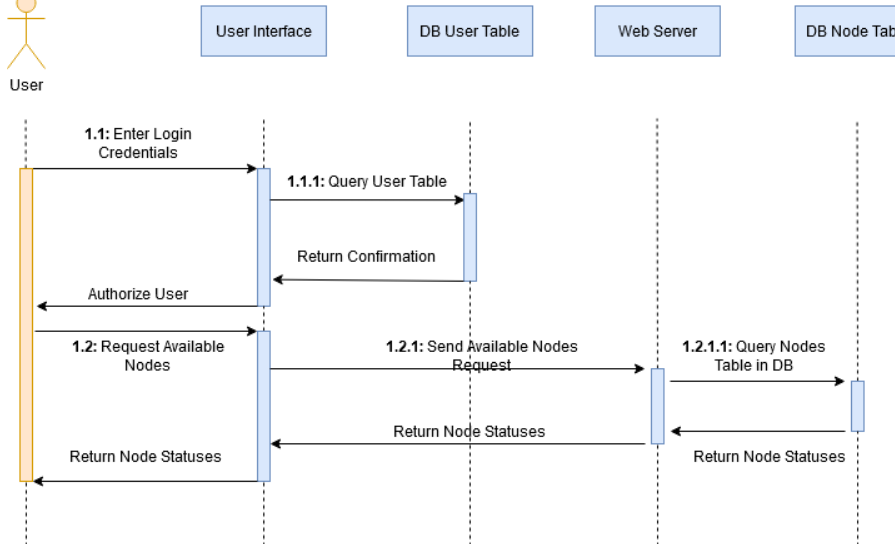
Figure 3. Retrieving Available Nodes Sequence